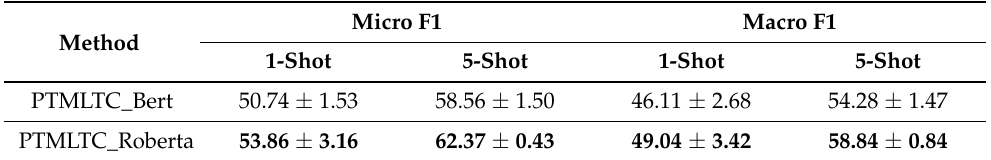
Table 4. Results of different PLMs on our dataset. Metrics marked in bold contain the highest metrics for the dataset.